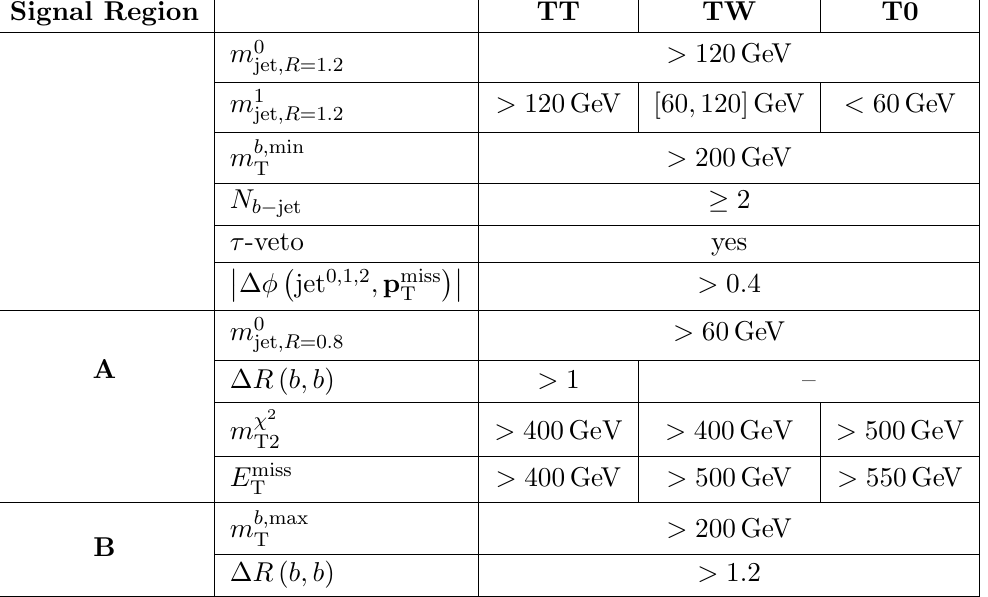
Table 1. Selection criteria for SRA and SRB, in addition to the common preselection require- ments described in the text. The signal regions are separated into topological categories based on reconstructed top-candidate